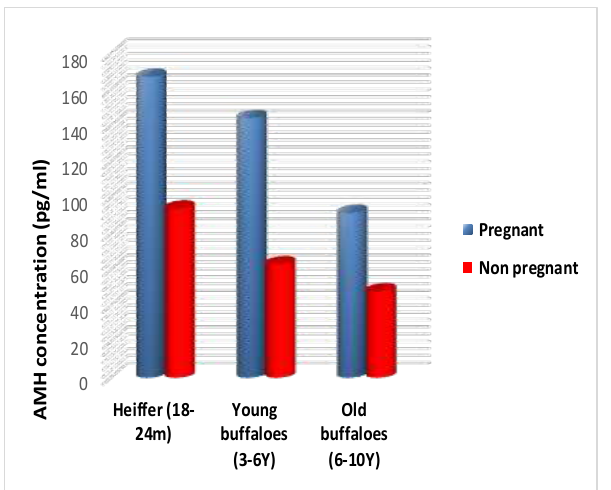
Fig. 2: Concentration of serum AMH in pregnant and non-pregnant buffaloes on 30th day after insemination The AMH concentrations were significantly higher in all the pregnant animals than in the animals with a pregnancy loss (P < 0.05) in the last examination performed on Day 60 of the pregnancy. The serum AMH concentrations of the pregnant animals and the animals with a pregnancy loss on Day 60 are shown in Table 3 and Fig.3. Table 3: The serum AMH concentrations from the day of insemination of the pregnant animals and the animals with a pregnancy loss detected on the 60 th day after insemination (lost between D30 and D60).